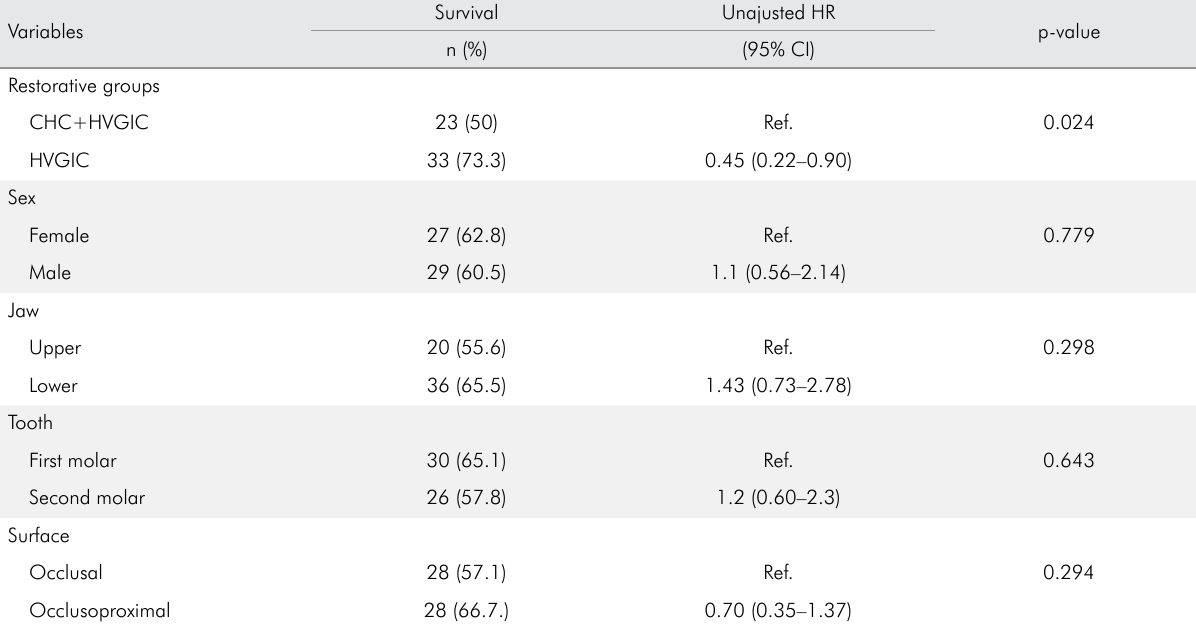
Table 4. Cox regression analysis (Hazard Ratio; 95% Confidence Interval) for failure of restorations according to explanatory variables.